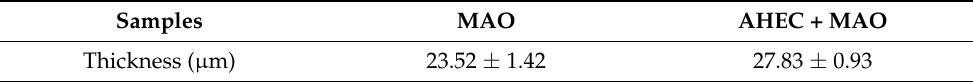
Figure 2. Cross-sectional morphologies of ( a – c ), MAO + AZ31 and ( d – f ) AHEC + MAO + AZ31. Table 1. Coating thickness of AZ31 substrate (mean ± standard deviation).